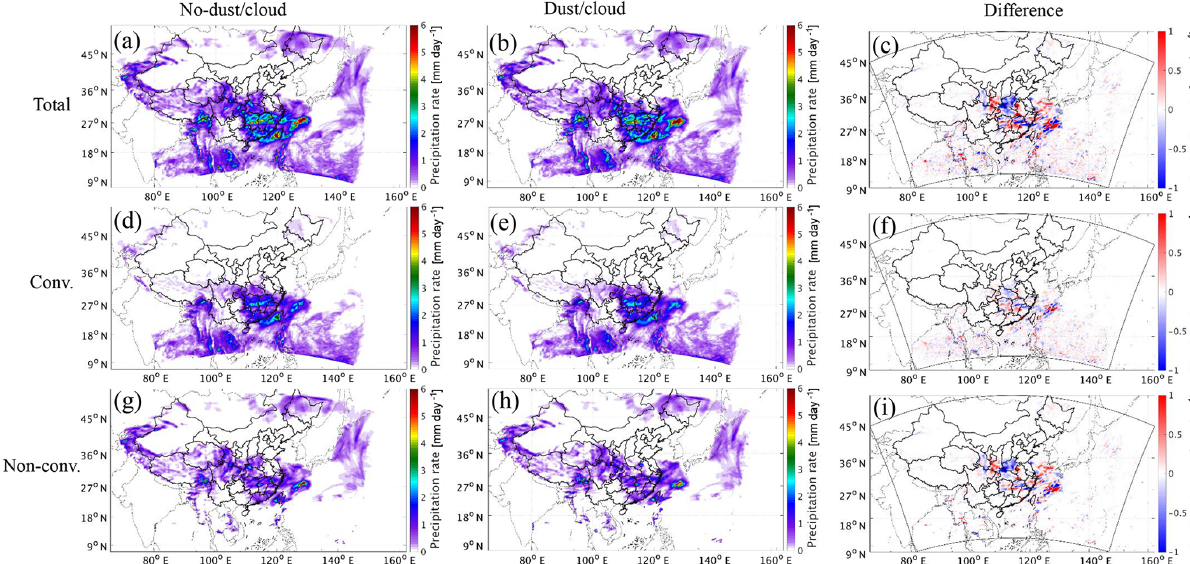
Figure 12. Spatial distributions of the average simulated total precipitation rate (a–c) , convective precipitation rate (d–f) , and non-convective precipitation rate (g–i) from NO-DUST/CLOUD (left panels), DUST/CLOUD (middle panels), and the difference between DUST/CLOUD and NO-DUST/CLOUD (right